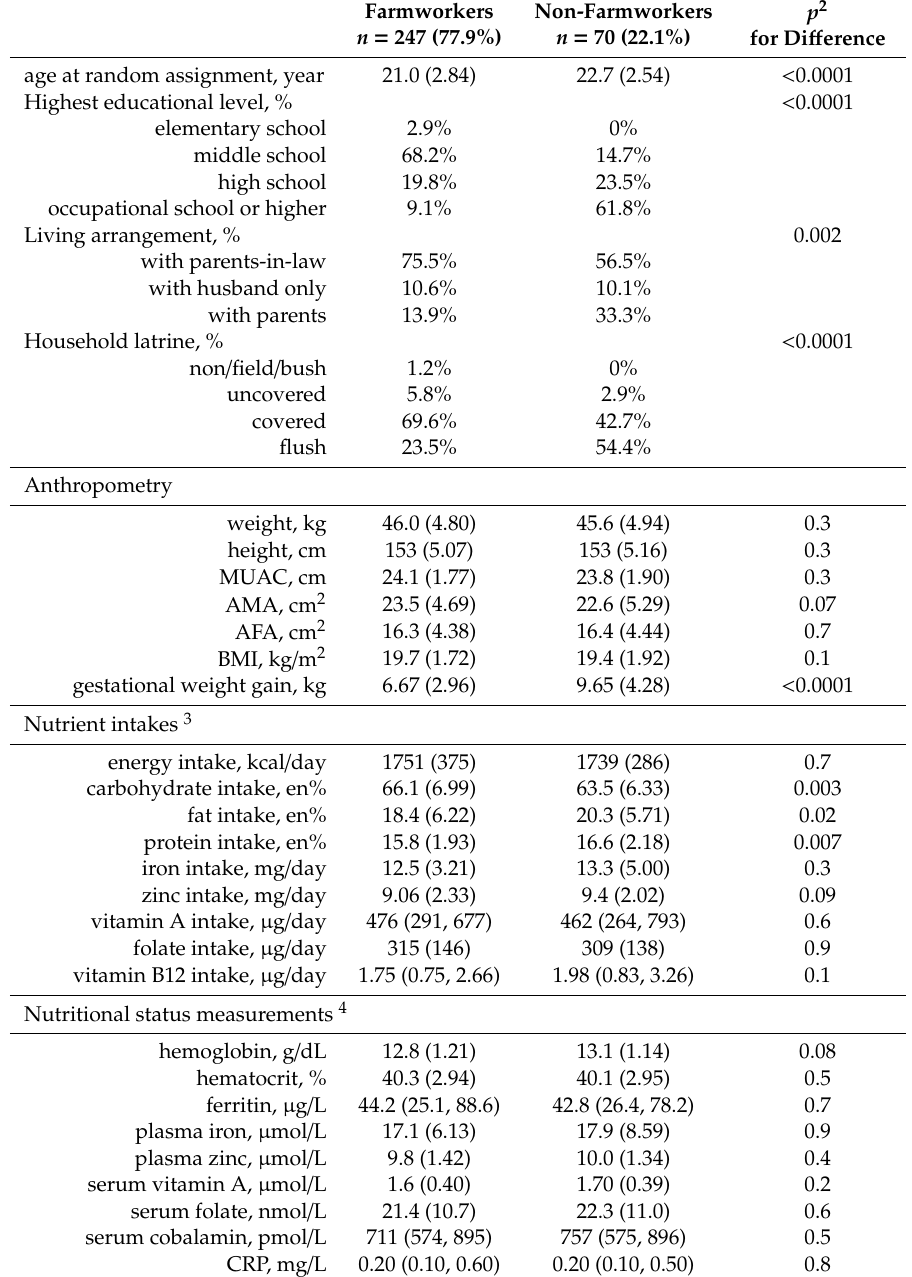
Table 2. Characteristics of the study population at baseline presented separately for farmworkers and non-farmworkers ( n = 317).